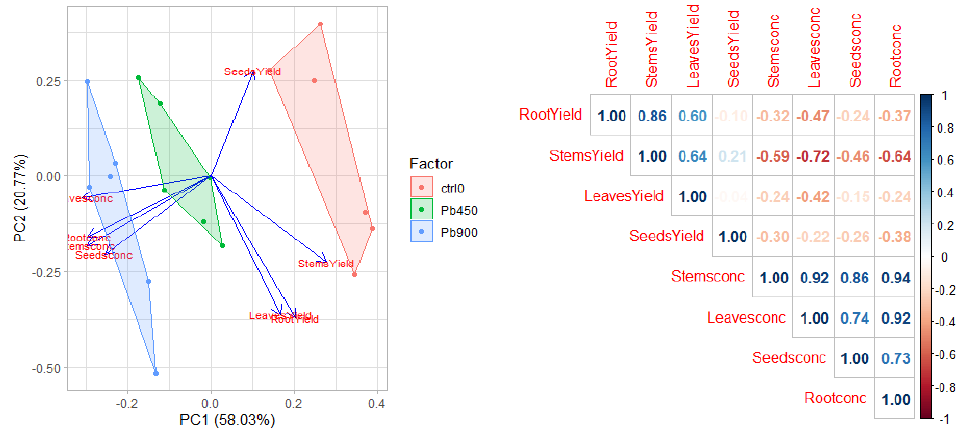
Figure 9. Principal component analysis and correlation matrix in lead-contaminated soil in the two years.